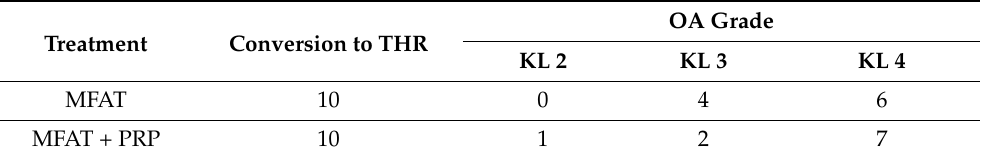
Table 5. Details of the patients who had a THR following treatment of their hip OA. The Kellgren– Lawrence (KL) grades are shown.